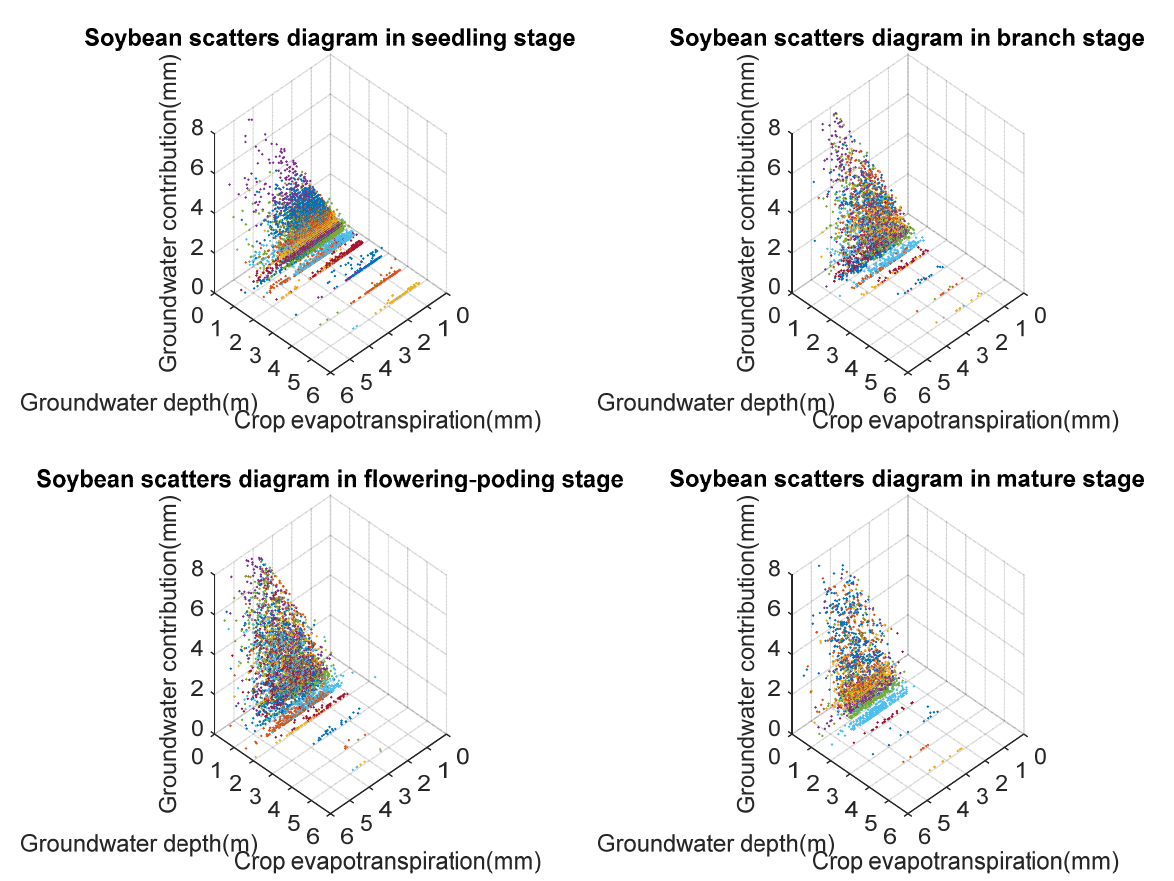
Figure 6. Three-dimensional scatter diagrams of groundwater depth, crop evapotranspiration, and the groundwater contribution of soybean in different growth periods.